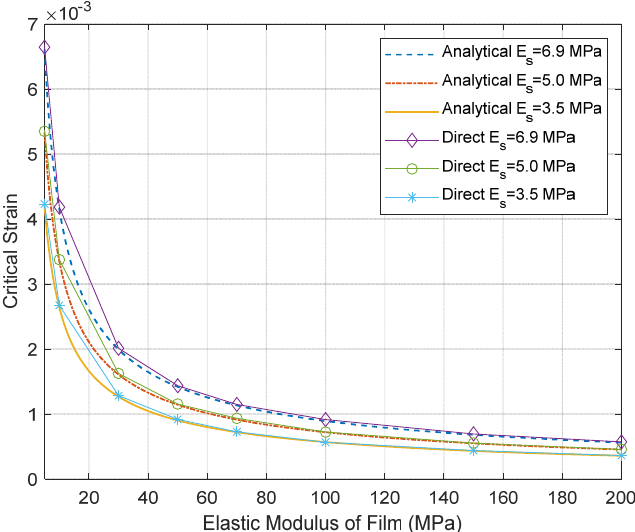
Figure 6. Critical strain as a function of elasticity of thin film for different substrate elasticity.